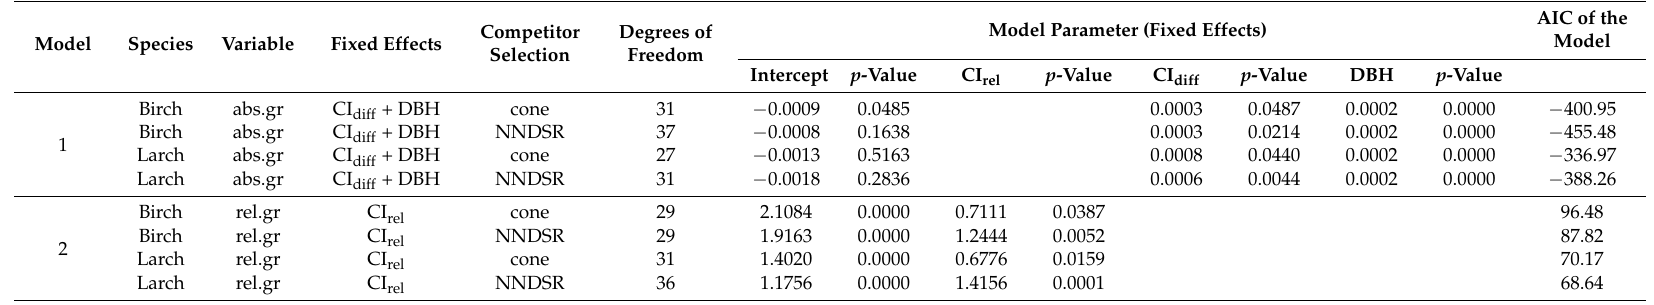
Table 5. Overview of the selected competition-growth models (fixed and mixed effect models). The different competitor selections are NNDSR = search radius class, based on the double NND; cone = cone method [44,45]. CI diff = difference in absolute competition before and after thinning; CI rel = relative competition relief; DBH = diameter at breast height of tree i at the end of the vegetation period 2009; AIC= Akaike‘s Information